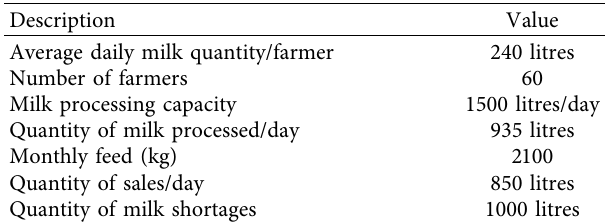
Table 4: Summary of farmer capacity.